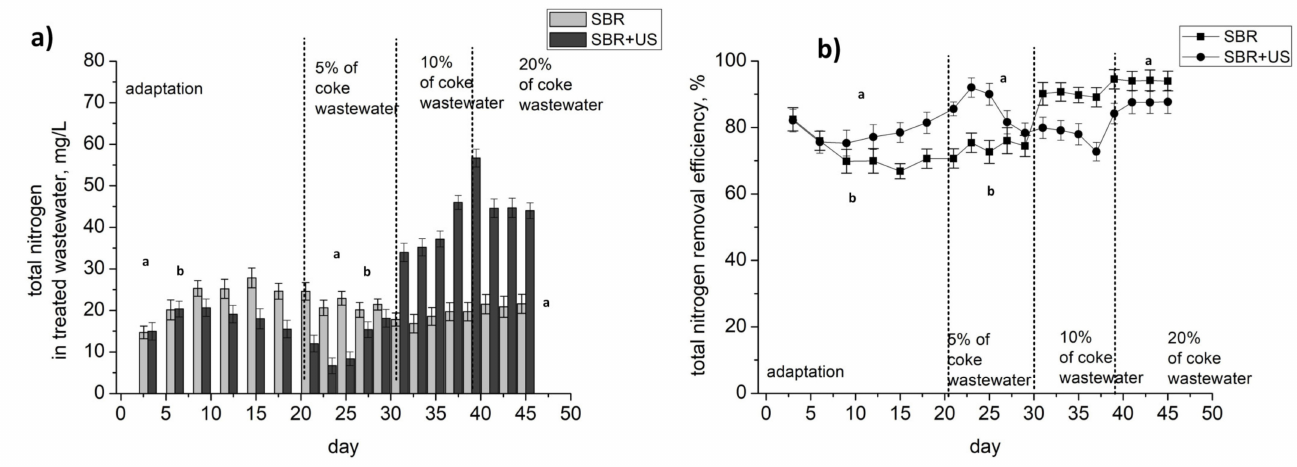
Figure 9. Total nitrogen (TN) changes during treatment in the SBR: ( a ) concentration; ( b ) removal efficiency (Statistical group